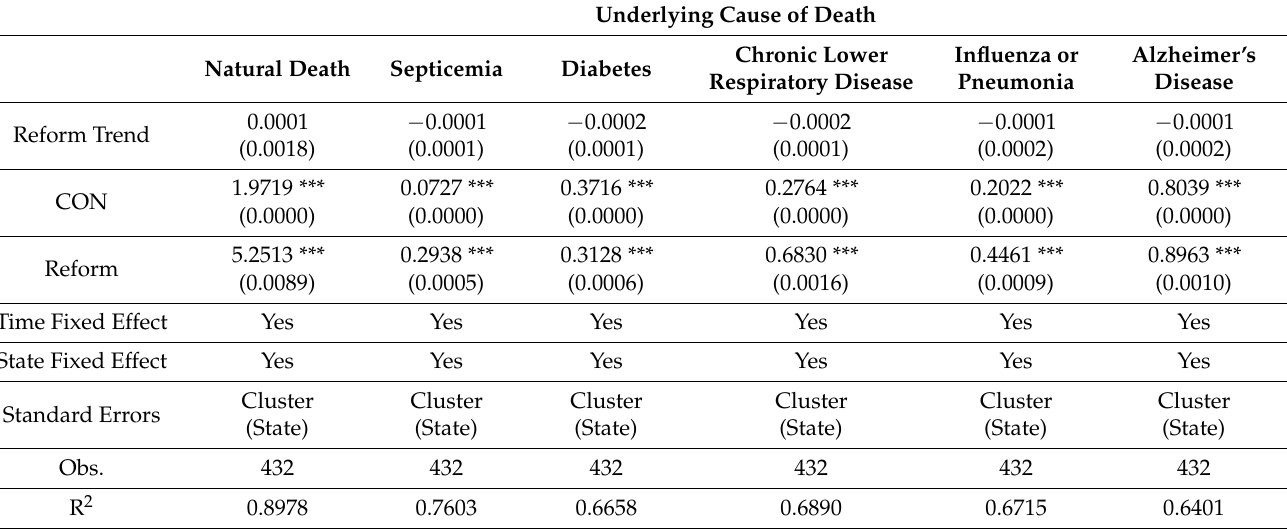
Table 3. Parallel trend estimates of the effect of reforming CON